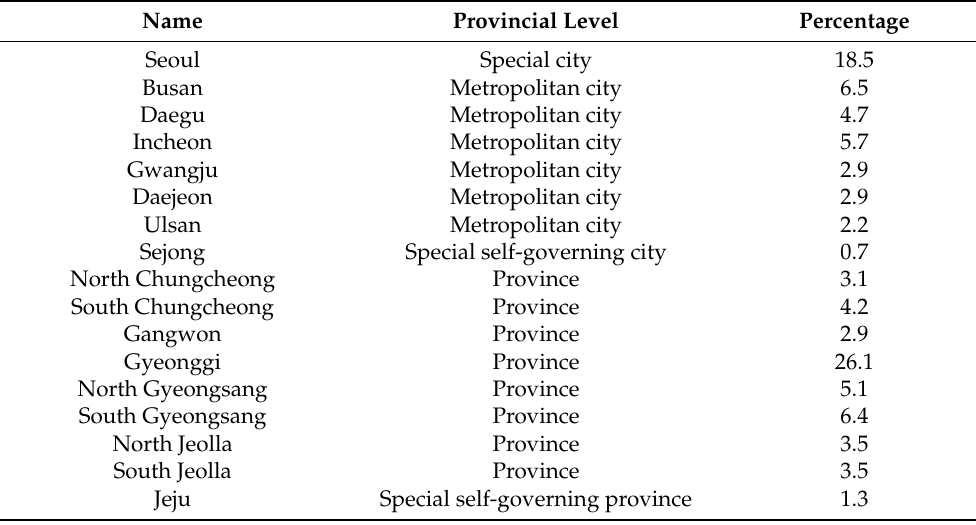
Table 1. Province and metropolitan city information for South